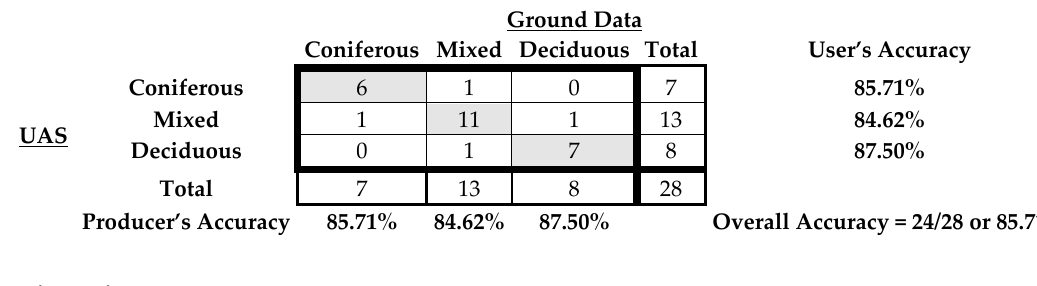
Table 8. UAS forest stand thematic map error matrix for CFI plot-registered samples. Ground (reference) data are represented by the CFI plots and Unmanned Aerial Systems (UAS) data are derived from the corresponding orthomosaic.